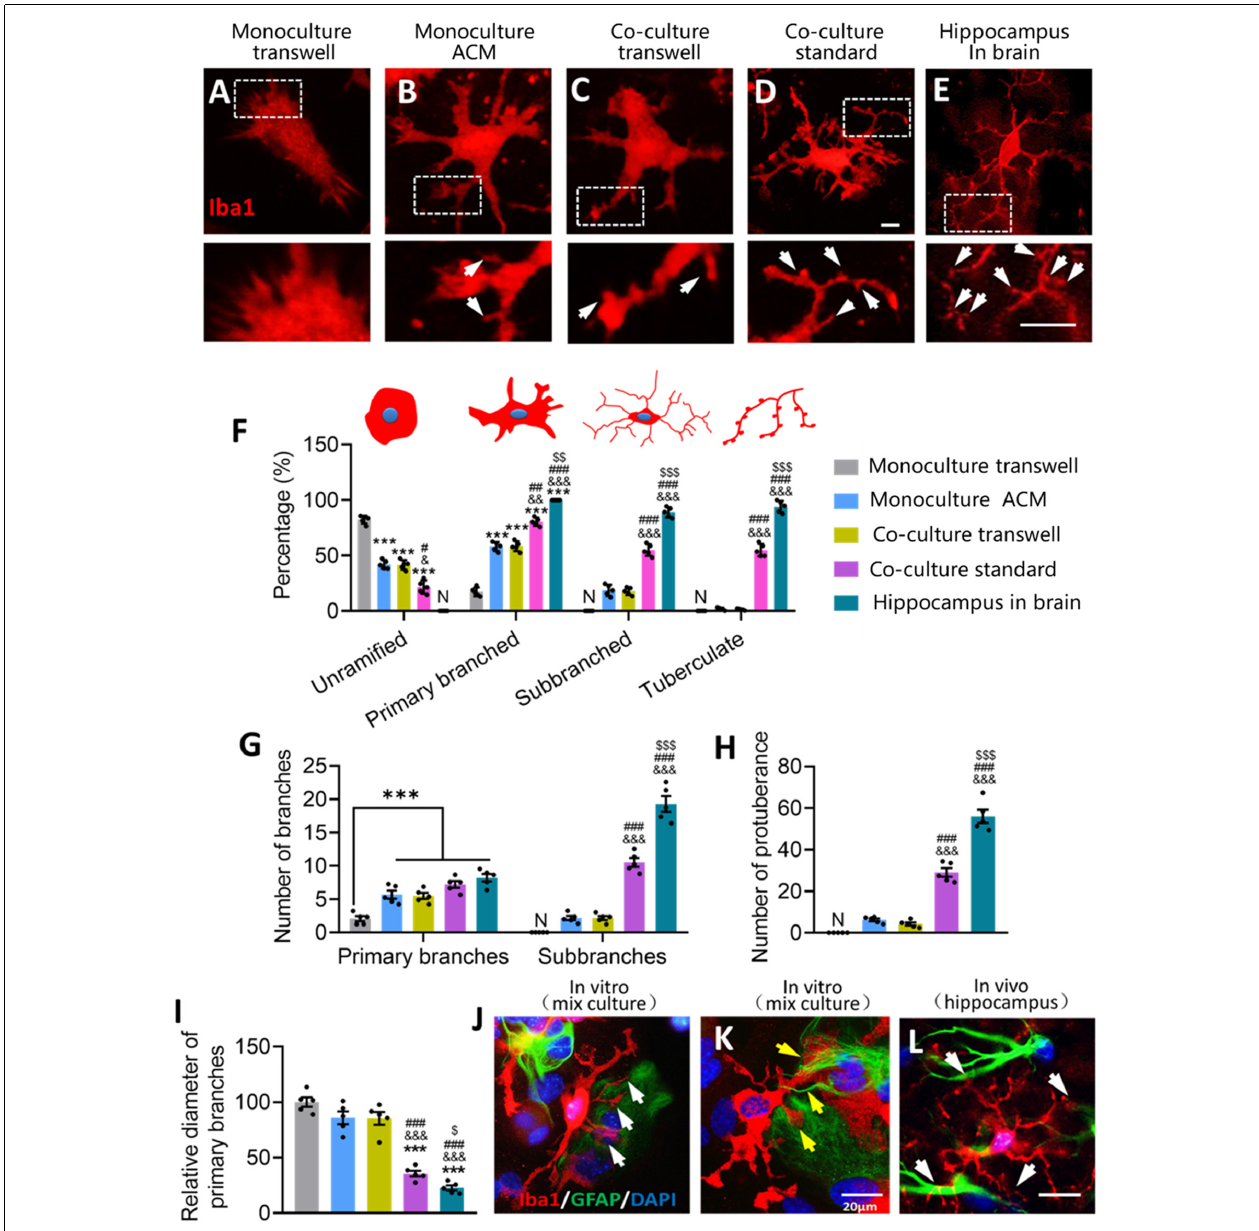
FIGURE 9 | Glial fibers from astrocytes promote the formation of microglial sub-branches and protuberance. (A–E) Fluorescence micrographs showing differences in the branch microstructure of microglia under different conditions. Microglia were labeled by Iba1 (red). White arrows indicate protuberances of microglia. Scale bar, 5 µ m. (F) Percentages of unramified microglia, primary branched microglia, sub-branched microglia, and tuberculated microglia under different conditions. (G) Numbers of primary branches and sub-branches in ramified microglia under different conditions. (H) Numbers of protuberance of microglia under different conditions. (I) Relative diameter of microglial primary branches under different conditions to the monoculture in fresh medium. (J) Fluorescence micrograph showing that microglia had more branches on the side where GFAP + cells were present than the side where GFAP + cells were absent. Microglia were labeled by Iba1 (red), astrocytes by GFAP (green), and nuclei by DAPI (blue). White arrows indicate the microglial ramification on the side where GFAP + cells were present. Scale bar, 20 µ m. (K) Fluorescence micrograph showing that glial fibers from astrocytes promote the formation of microglial sub-branches and protuberance. Yellow arrows point to glial fibers that wind and induce microglia branching. Scale bar, 20 µ m. (L) Representative immunofluorescence micrograph showing distribution of the astrocyte marker GFAP and the microglial marker Iba1 in the hippocampus. White arrows indicate microglial branches growing toward GFAP + cells. Scale bar, 20 µ m. Results of each group were obtained from five independent samples, and 4–5 micrographs were collected for each sample. All Iba1 + cells in each micrograph were measured. Each dot in the bar graph represents the average of each simple. Data are presented as mean ± SEM, *** P < 0.005 vs. Monoculture transwell group, & P < 0.05, && P < 0.01, and &&& P < 0.005 vs. Co-culture transwell group, # P < 0.05, ## P < 0.01, and ### P < 0.005 vs. monoculture ACM group, $ P < 0.05, $$ P < 0.01, and $$$ P < 0.005 vs. co-culture standard group [ n = 5, N: no (the corresponding number is "0") unpaired two-tailed Student’s t -tests or two-way ANOVAs, followed by Tukey’s multiple-comparison test, where